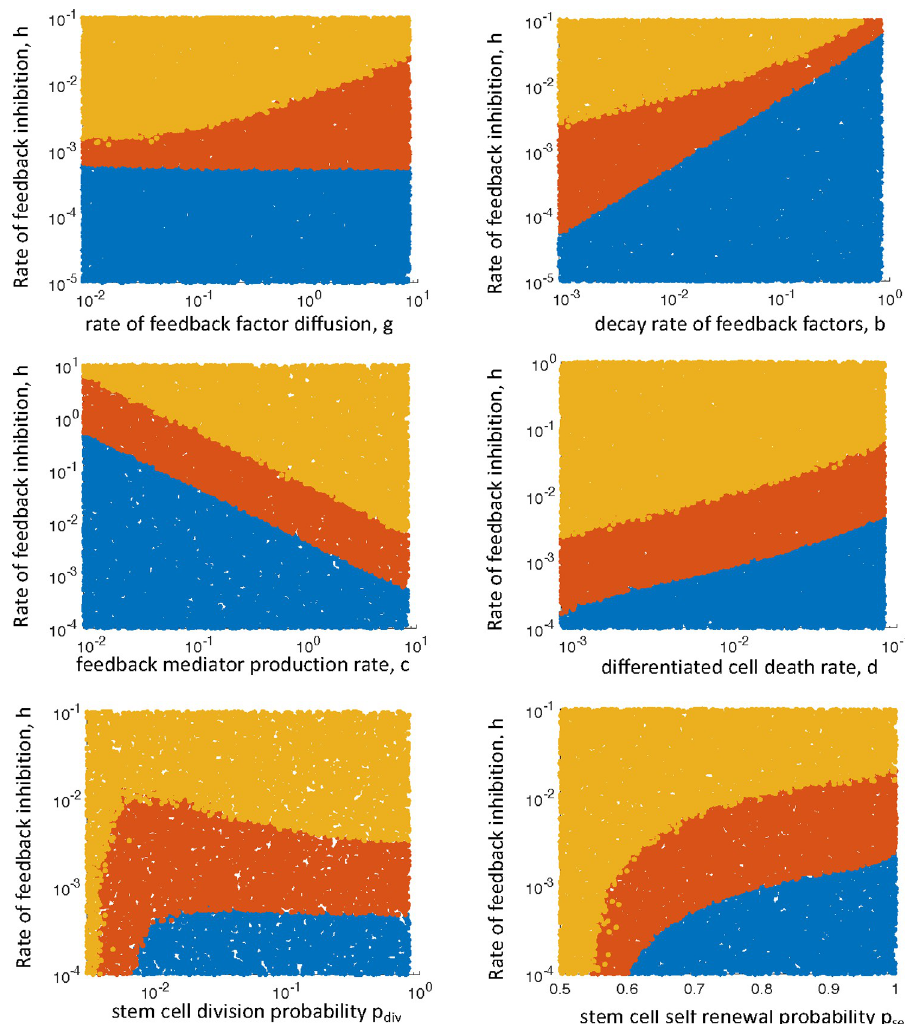
Fig 3. Parameter dependencies of outcome. Each dot in the graph represents the long-term outcome of an individual simulation. Each simulation was run up to a time threshold, and the spatial distribution was determined by calculating I disp , the index of dispersion. The time threshlold was determined by waiting until the temporal average of the stem cells did not change by more than 0.1% for 1000 consecutive time steps, after which the simulation was allowed to run for an amount of time that corresponds to 10 years in the simulation, to ensure that the dynamics are well in the steady state pase. Yellow indicates the extinction of the cells. Blue indicates a distribution that is characterized by I disp < 1.5 (mostly uniform distribution). Red indicates I disp > 1.5 (clumped distribution of cells). For each graph, two parameters were varied: the strength of negative feedback on the stem cell self-renewal probability, h, and a second parameter, as indicated in the individual graphs. The ranges of the parameters were chosen such that all three outcomes are seen, to illustrate how the different outcomes depend on parameters. Baseline parameters were chosen as follows. P div = 4.17x10 -2 , p (0) self = 0.7, P Sdeath = 8.3x10 -4 , P Ddeath = 4.17x10 -3 , p mig = 0., c = 8.33, b = 8.3x10 -3 , g = 0.833; n = 200. Units of rate parameters are in hours -1